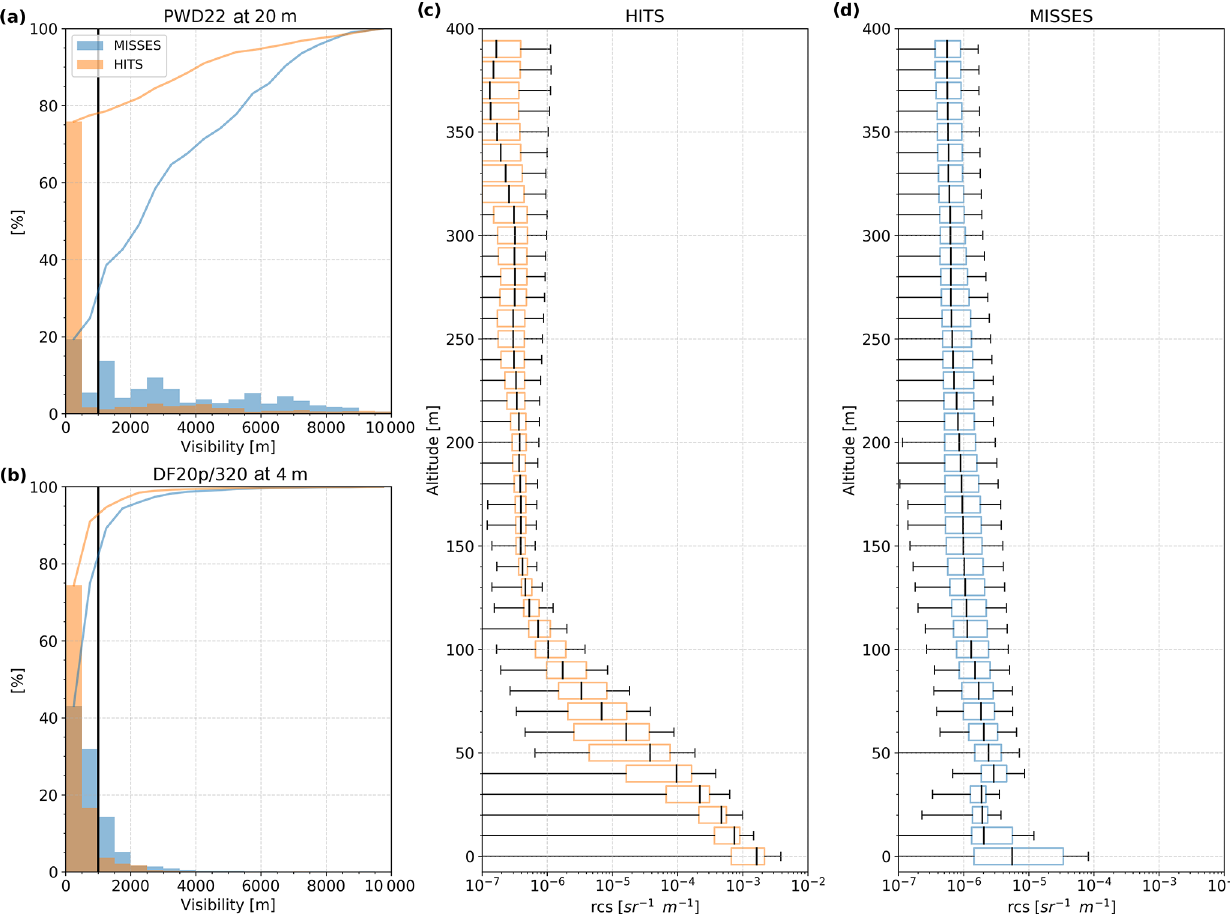
Figure 3. Characterization of the first 60min of radiation fog events recorded at SIRTA according to the performance of PFG1. Visibility distribution at 20m (a) and 4m (b) , as well as boxplots of ALC-attenuated backscatter profiles associated to hits (c) and misses (d) .